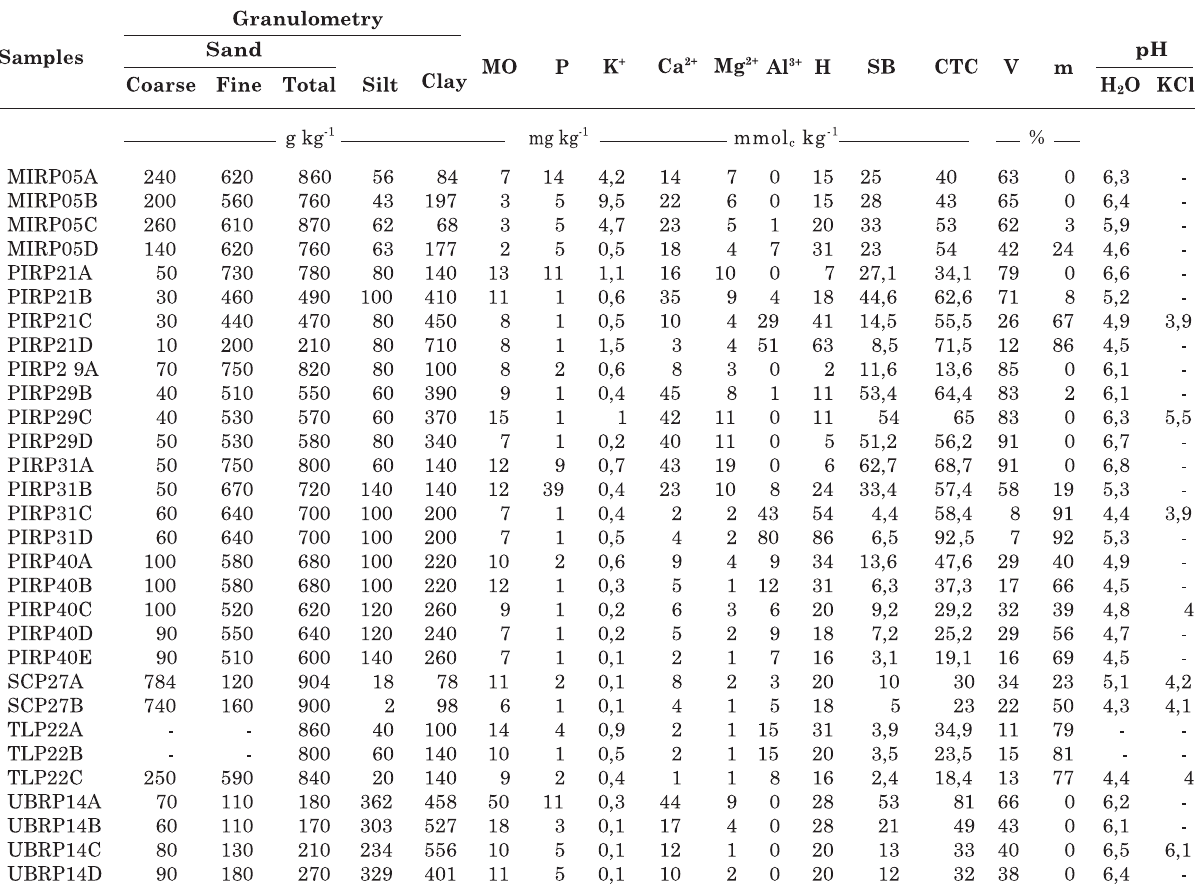
Table 2. Chemical and Granulometrical Analysis from soil profile samples MIRP05, PIRP21,